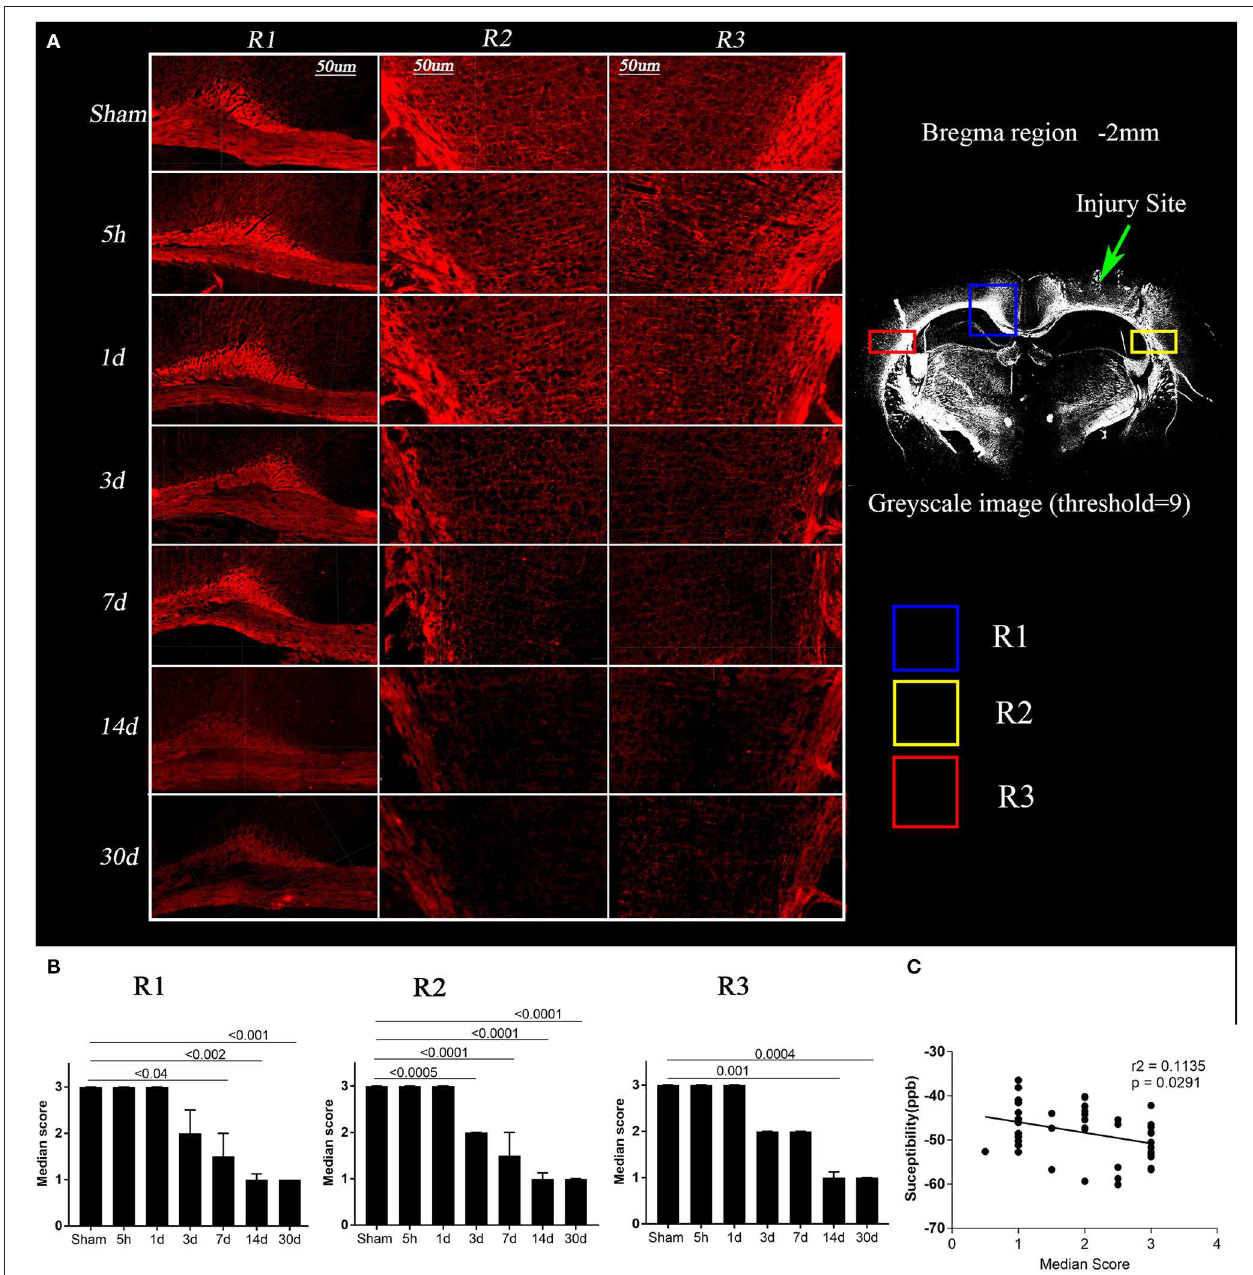
FIGURE 4 | Loss of myelin basic protein (MBP) expression post-injury and its correlation with susceptibility. (A) Images depicting regions R1, R2, and R3 for a representative mouse from the sham and TBI groups at each time point are shown, red = MBP (in left). A 20 × greyscale image from a TBI animal (in right) from bregma region − 2mm has been shown to highlight the regions R1, R2, R3. Whole brain images were opened in IMARIS and were zoomed in to the scale bar = 50 µ m to crop the regions of interest. (B) Semi-quantitative analysis results for MBP immunoreactivity were plotted, indicating a significant loss of MBP binding over time in day 3, 7, 14, and 30 TBI groups as compared to the sham group. Kruskal–Wallis tests with Dunn’s multiple comparisons post tests were performed. Median and interquartile range were plotted with corrected p -values. (C) In R3, loss of MBP immunoreactivity was significantly correlated with increased quantitative susceptibility values, Pearson